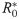
(a) Number of new infections per day divided by the actual number of individuals responsible for those infections for different values of mobility restriction (R0). (b) Number of new infections per day by the total number of infected on that day for different values of mobility restriction (R0*).